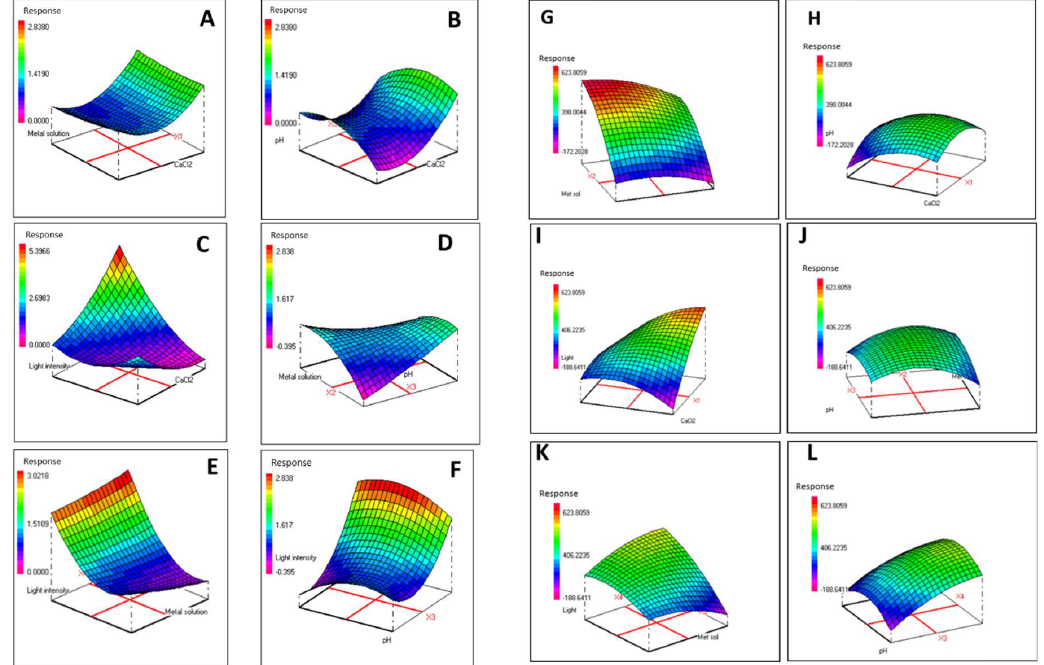
Figure 3. Response surface plots for PE production ( A - F ) and biomass accumulation ( G - L ) as a function of the different studied variables: ( A ) metal solution and CaCl 2 concentration; ( B ) CaCl 2 concentration and pH; ( C ) light intensity and CaCl 2 concentration; ( D ) pH and metal solution; ( E ) metal solution and light intensity; ( F ) light intensity and pH; ( G ) metal solution and CaCl 2 concentration; ( H ) CaCl 2 concentration and pH; ( I ) light intensity and CaCl 2 concentration; ( J ) pH and metal solution; ( K ) metal solution and light intensity; ( L ) light intensity and pH.